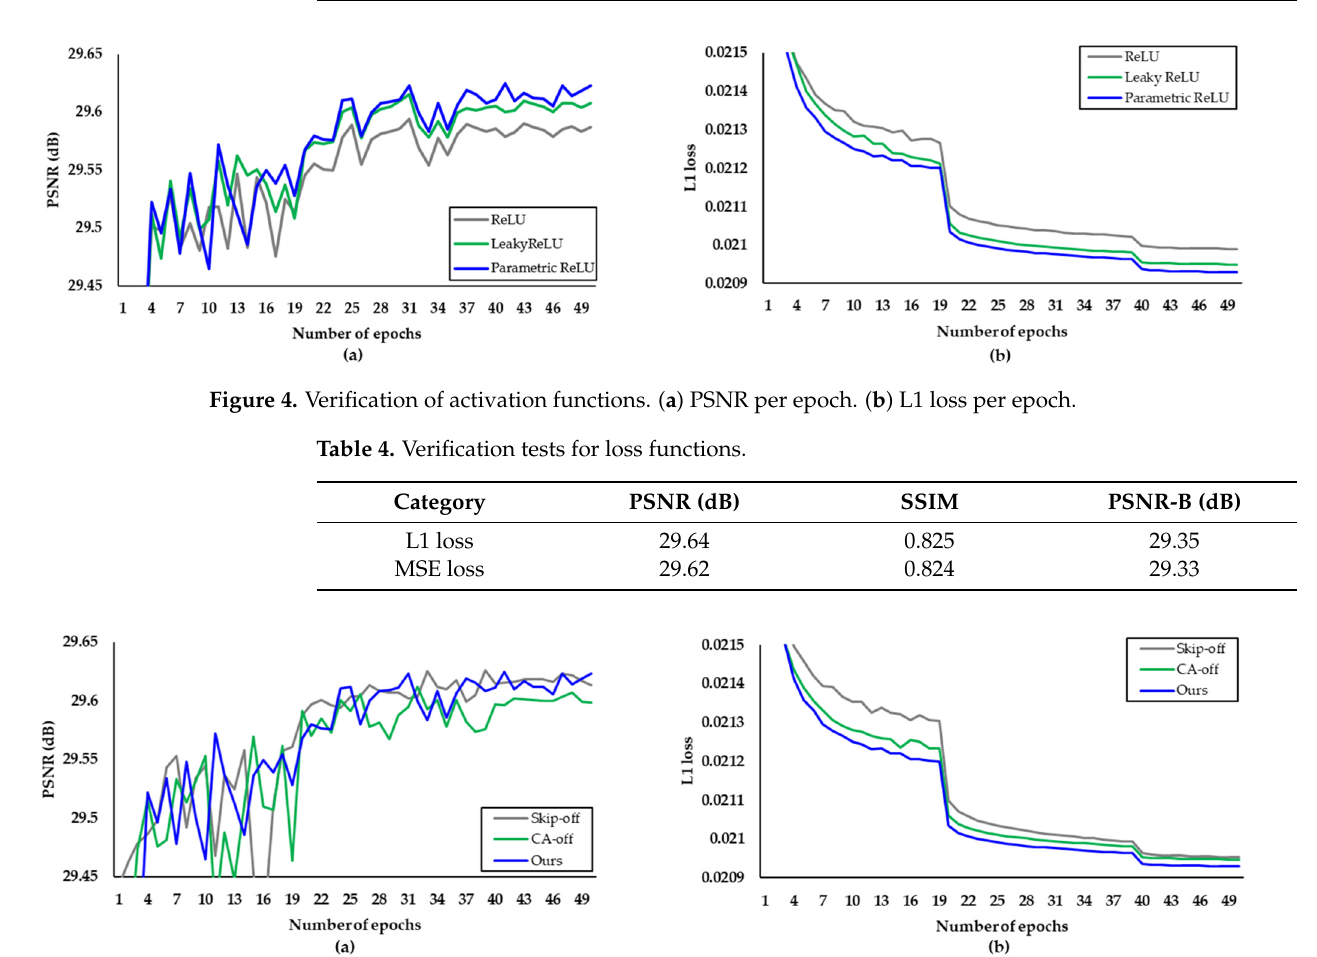
Figure 6. Verification of the number of DC blocks (DC) in terms of AR performance and complexity by using the Classic5 dataset. The circle size represents the number of parameters. The x and y-axis denote the total memory size and PSNR, respectively.